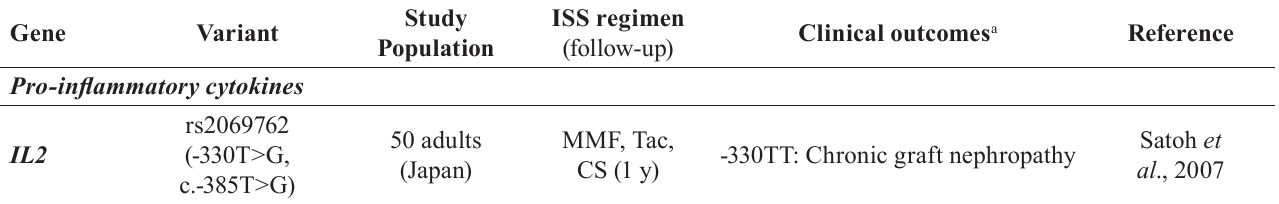
TABLE III - Genes related to cytokines and immune innate response in kidney recipients on MPA therapy with significant associations Gene Variant